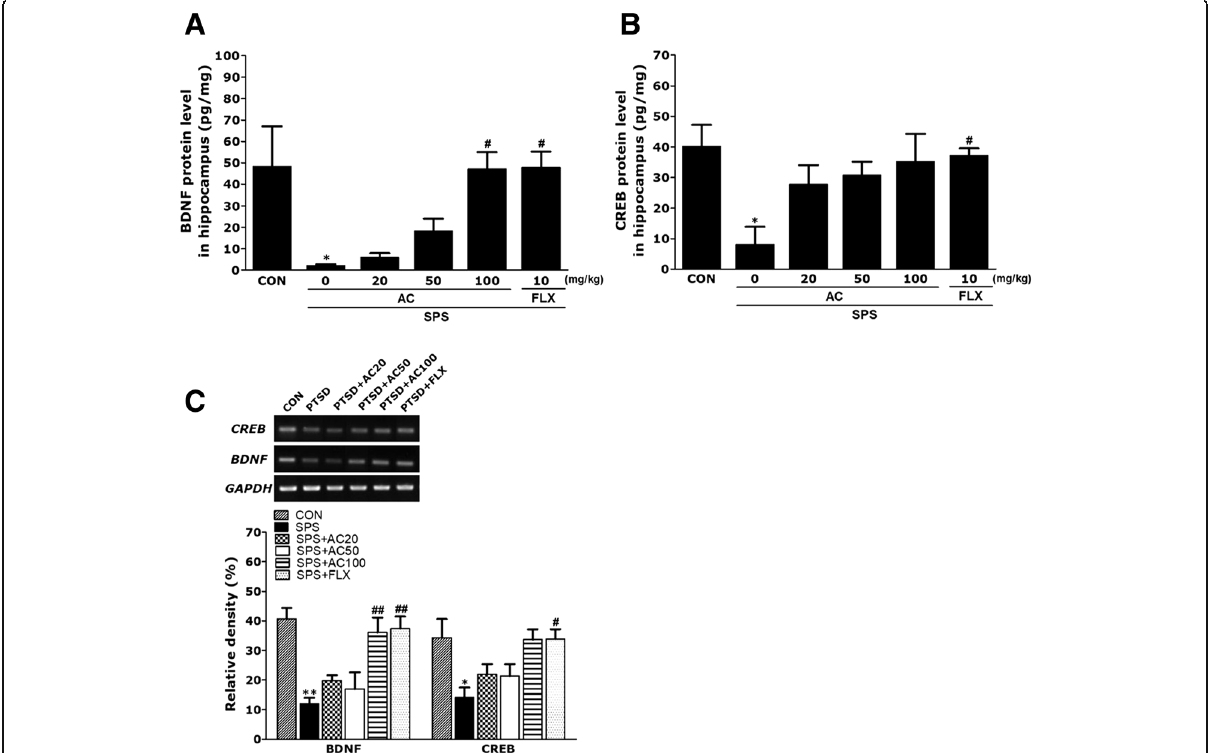
Fig. 5 Effects of AC on brain-derived neurotrophic factor (BDNF) and cAMP-response element-binding protein (CREB) protein levels ( a and b ) and mRNA expression in the hippocampus of rats with SPS-induced memory impairment. Polymerase chain reaction (PCR) bands on agarose gels and relative intensities are shown in ( c ). The mRNA expression levels of BDNF and CREB were normalized to that of glyceraldehyde 3-phosphate dehydrogenase (GAPDH) mRNA as an internal control ( n =4/group). * p <0.05, ** p <0.01 vs. the CON group, # p <0.05, ## p <0.01 vs. the SPS